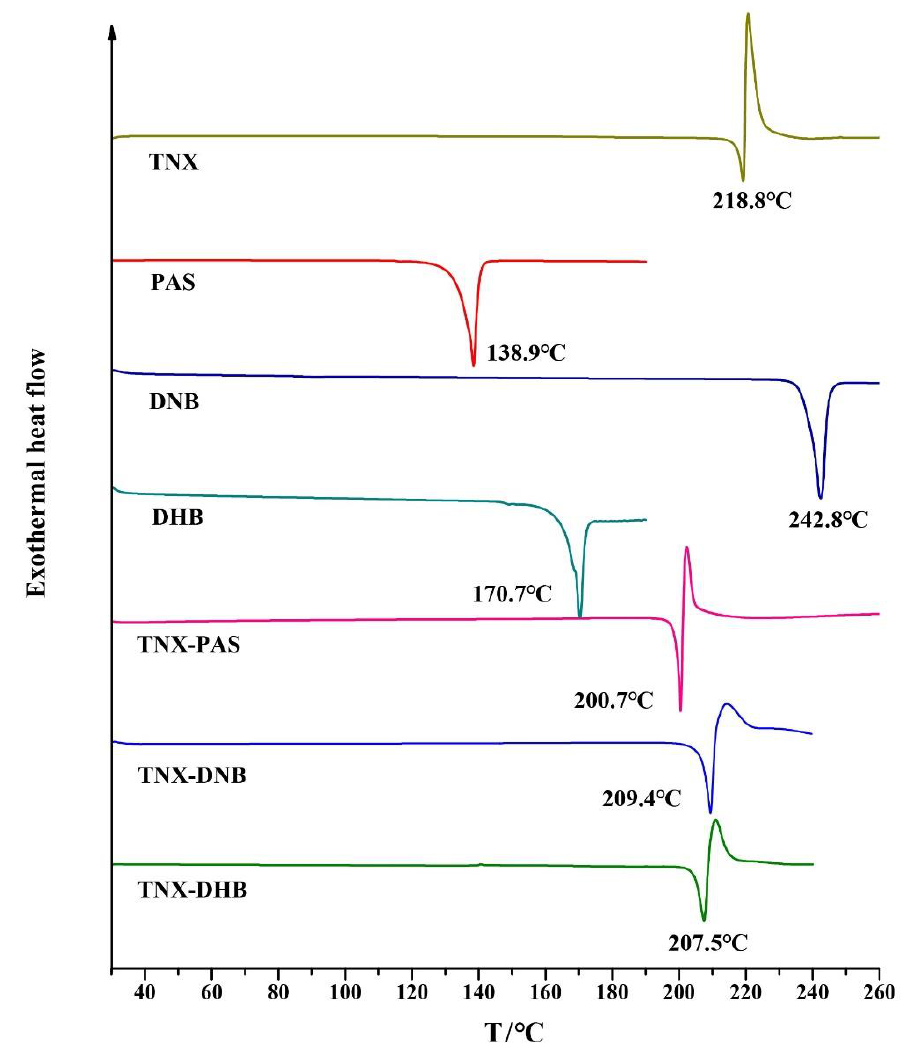
Figure 6. DSC profiles of TNX, CCFs, and the corresponding cocrystals/salt.